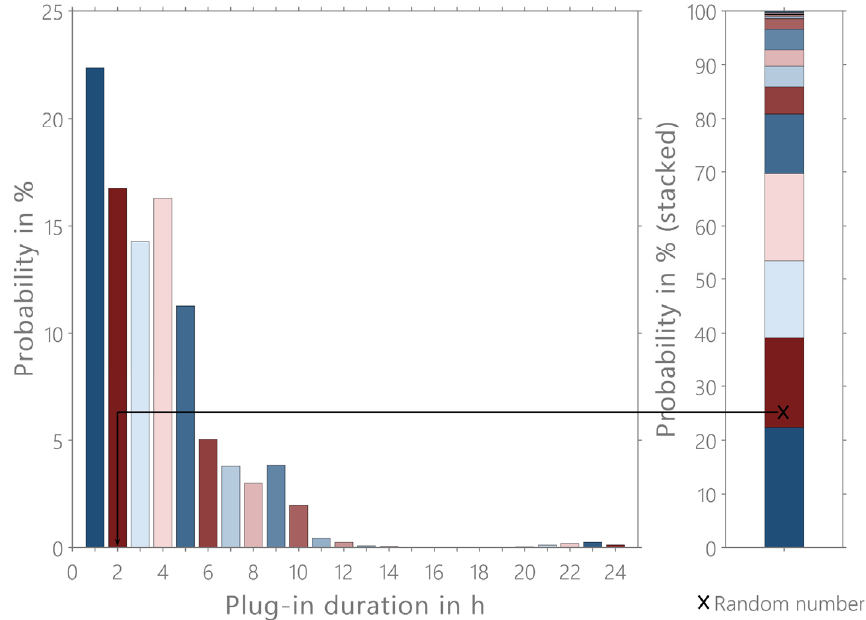
Figure 14. Exemplary representation of the process for selecting the plug-in duration in hourly resolution for the time period from 8:00 to 9:55 a.m.